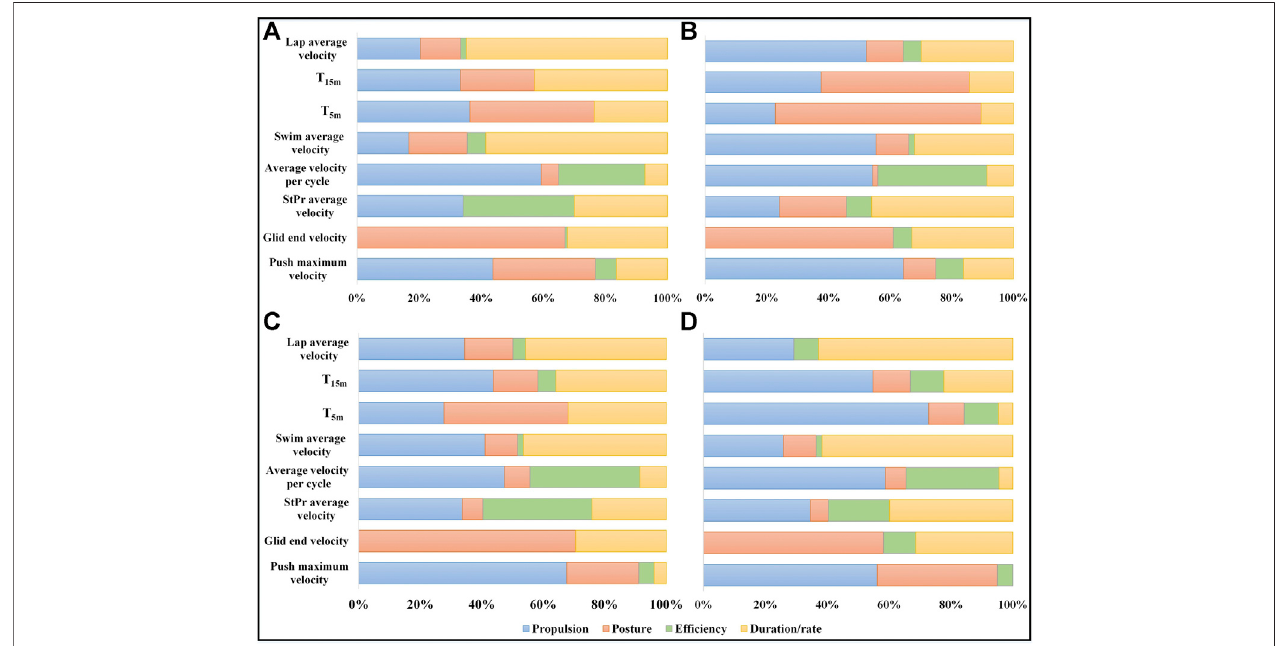
FIGURE 4 | Variable categories contribution to goal metrics estimation for front crawl (A) , breaststroke (B) , butter fl y (C) and backstroke (D) . The contribution of each category (propulsion: blue, posture: orange, ef fi ciency: green, duration/rate: yellow) is represented in percent for estimating the corresponding goal metric. The results are based on the variables with higher than 5% relative weight in LASSO variable